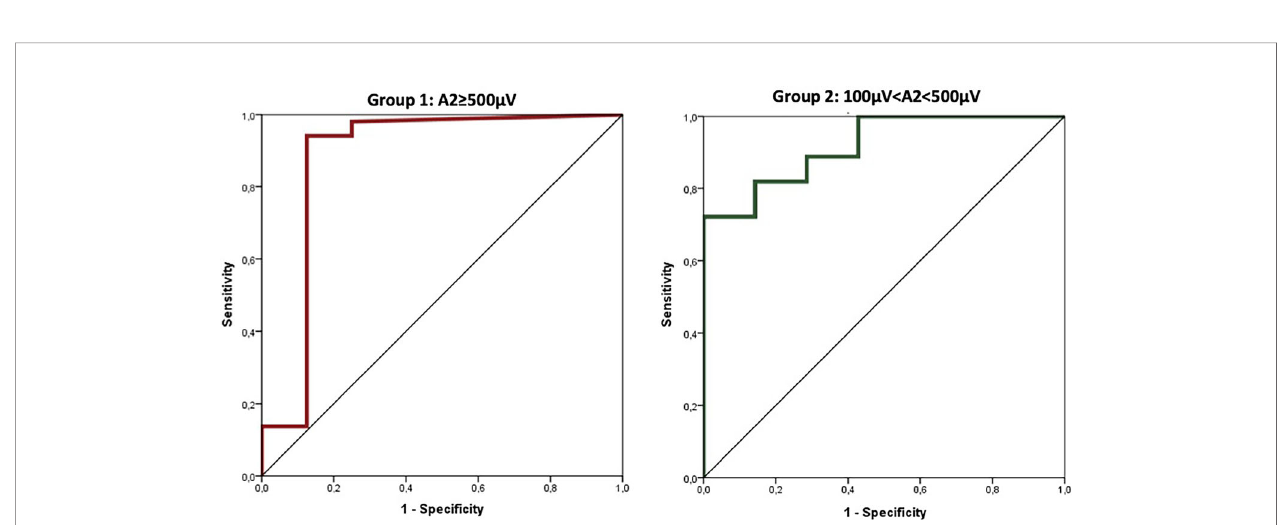
FIGURE 2 | ROC curves analysis for diagnostic accuracy of amplitude reduction in VCP detection.